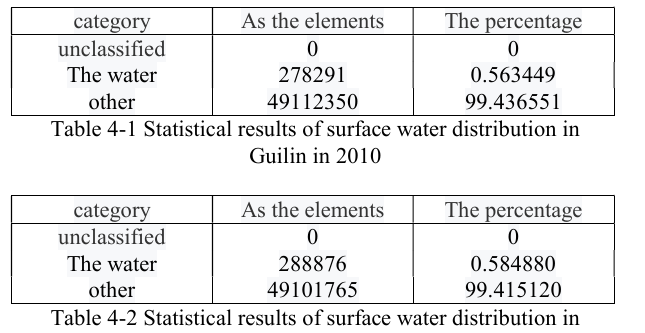
Figure 4-2 surface water resources of Guilin in 2010, 2013 and 2016 Annual runoff of Guijiang river in 2010, 2013 and 2016 in Guilin is shown in figure